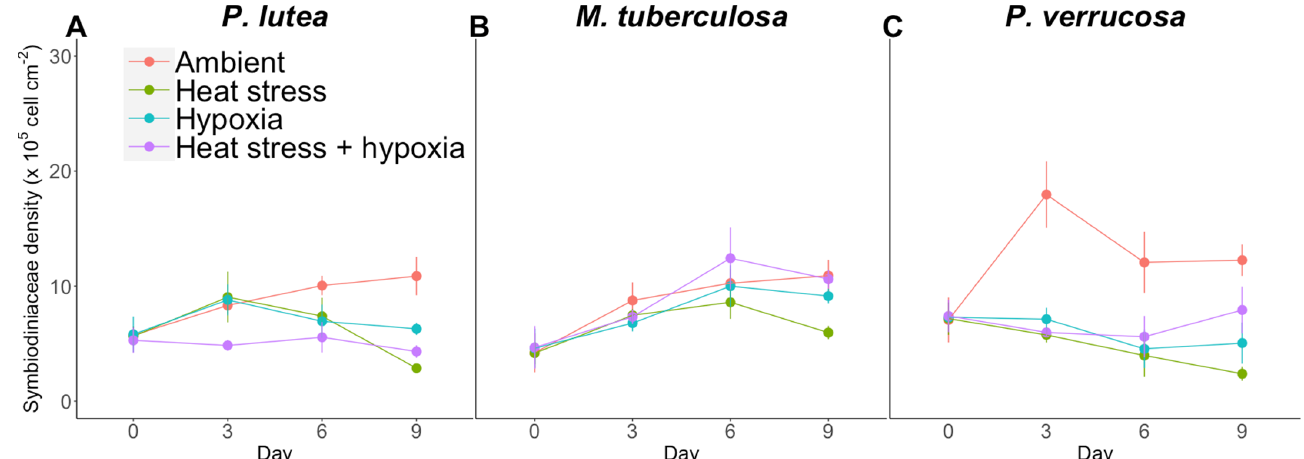
Figure 4. Symbiodiniaceae density (× 10 5 cells cm − 2 ) of P. lutea ( A ), M. tuberculosa ( B ), and P. verrucosa ( C ) under ambient baseline conditions, heat stress, hypoxia, and heat stress + hypoxia on days 0, 3, 6, and 9. Data are shown as mean ± SE ( n = 4).